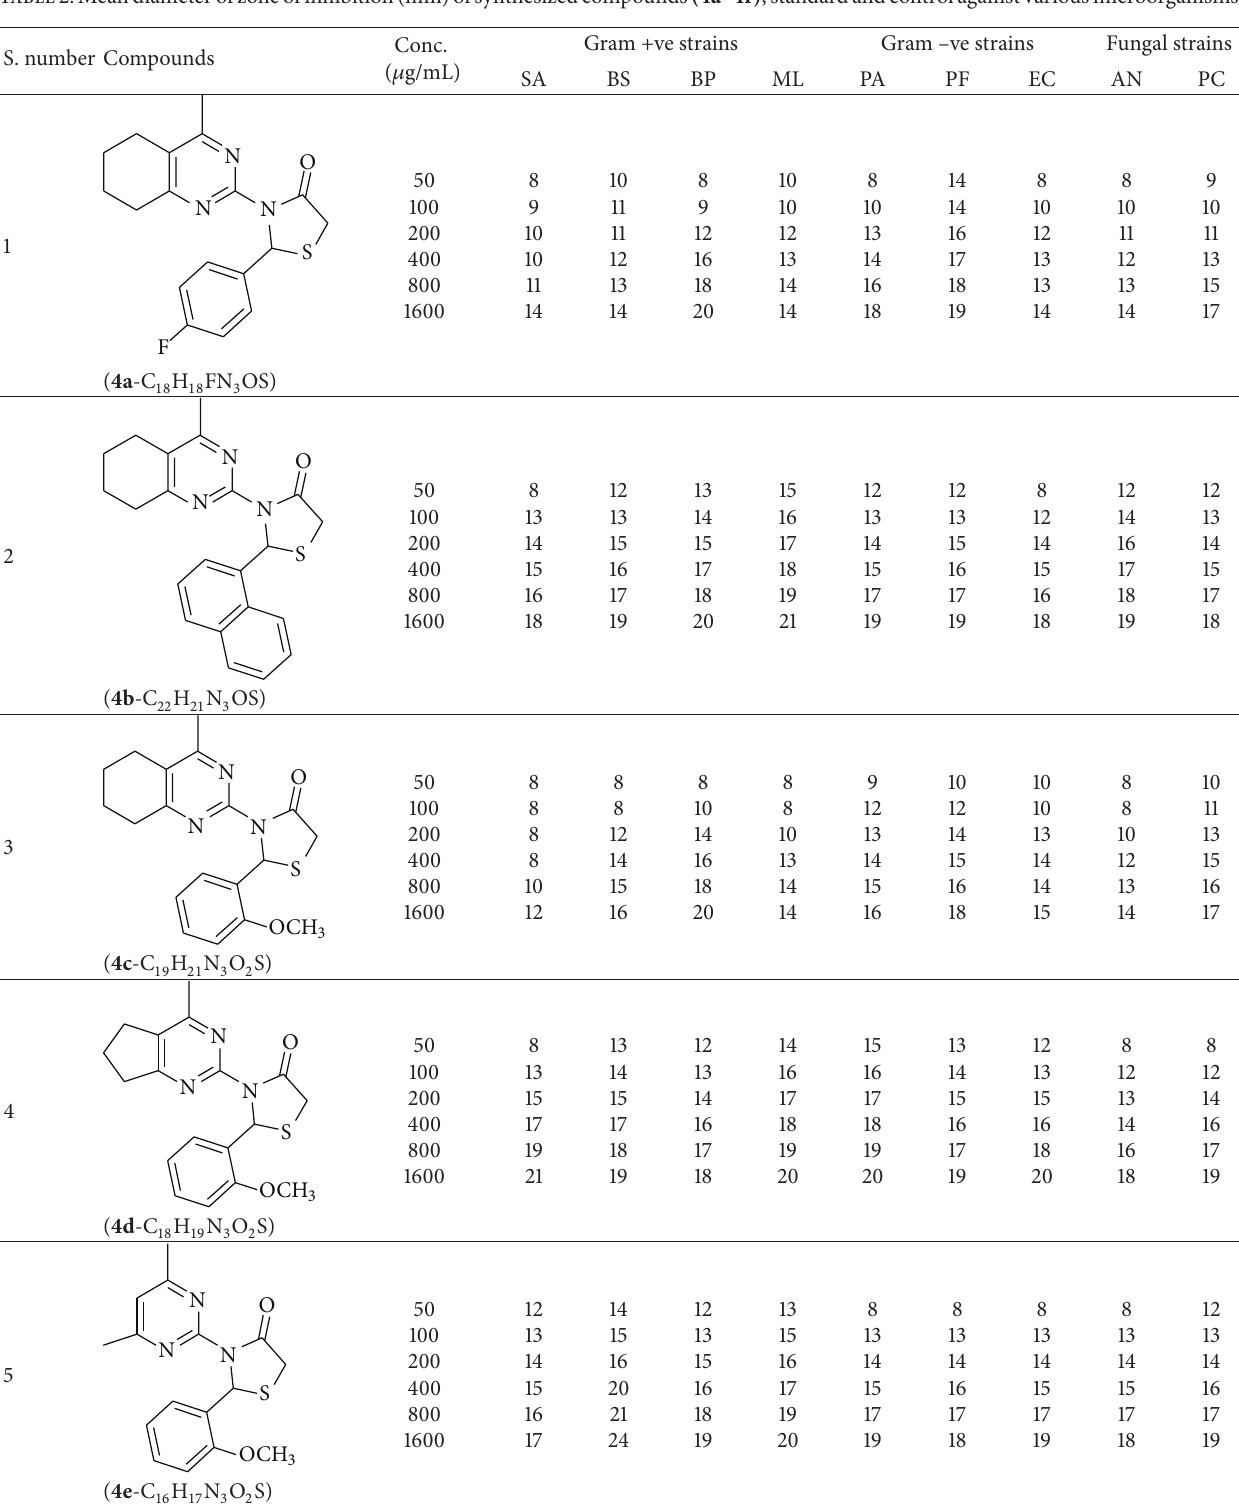
Table2:Meandiameterofzoneofinhibition(mm)ofsynthesizedcompounds (4a–4f) ,standardandcontrolagainstvariousmicroorganisms. S. number